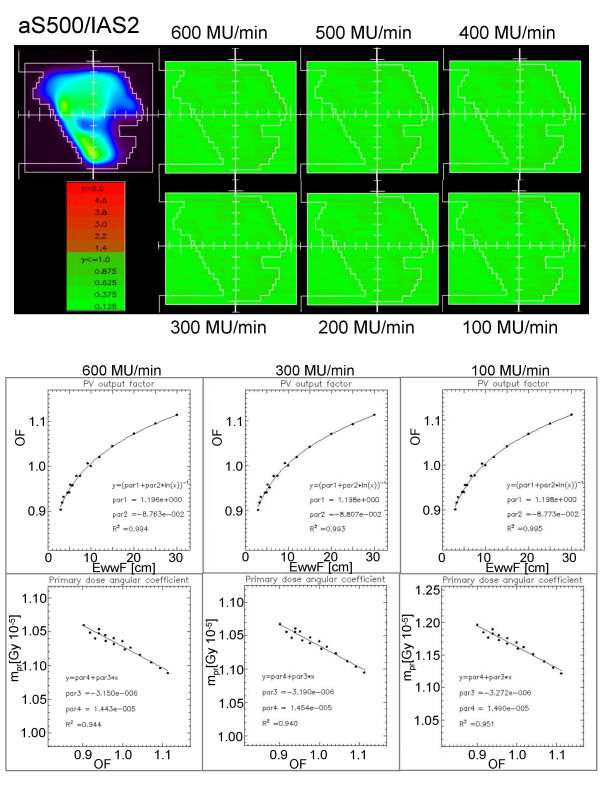
Summary of Dose Rate independence study for the IAS2 read-out electronics (associated to the PV-aS500 detector). Example of Gamma Evaluation matrices (DTA = 3 mm, ΔD = 3%) for a field measured with beam delivery operated at dose rates from 100 to 600 MU/min while dose calculation was performed at 300 MU/min. Plots of the calibration data acquired at different dose rates and corresponding fits.